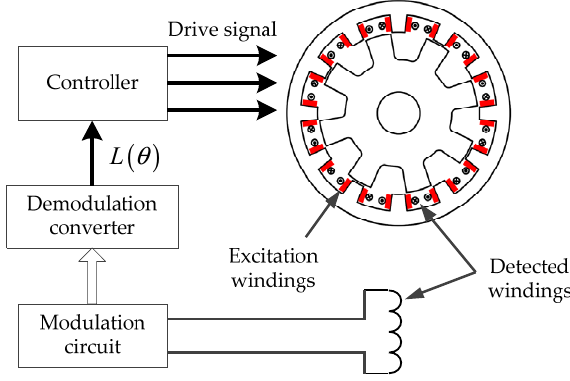
Figure 10. Position estimation method based on additional